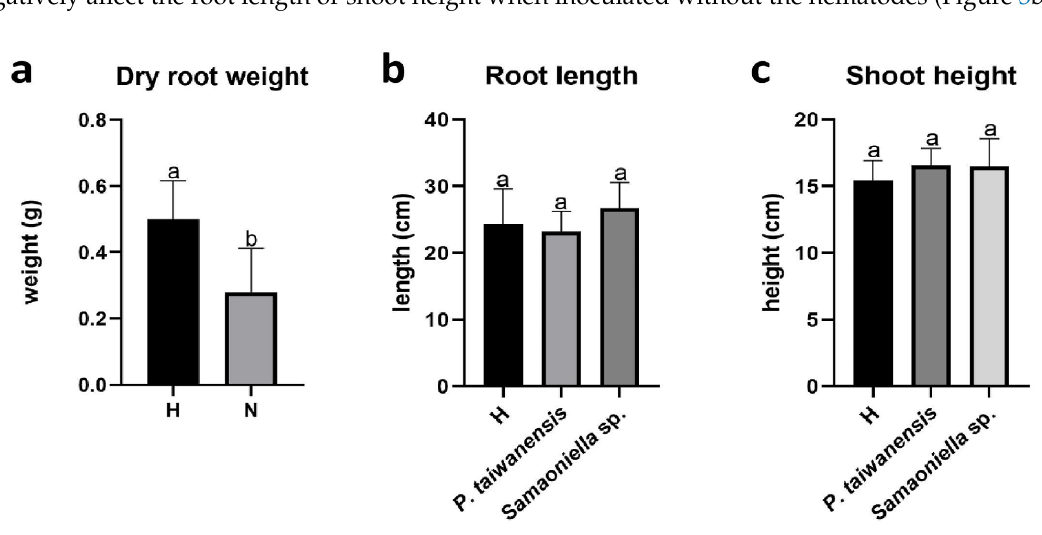
Figure 3. Plant growth parameters in greenhouse trial 1. ( a ) negative e ff ect of M. enterolobii on dry root weight, ( b ) P. taiwanensis and Samsoniella sp. strain NTUCC 18–159 e ff ects on root length, and ( c ) shoot height. H is the healthy control. N is the nematode-only treatment. Di ff erent letters indicate